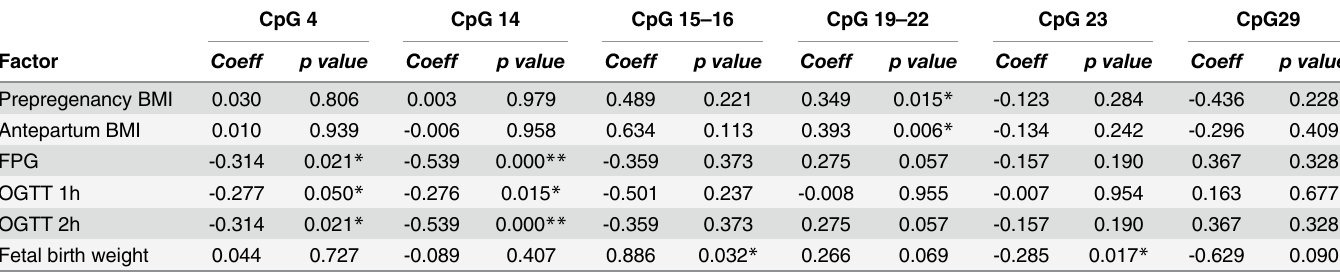
Table 5. Linear Regression of H19 Methylation on Fetal Birth Weight and Related Impact